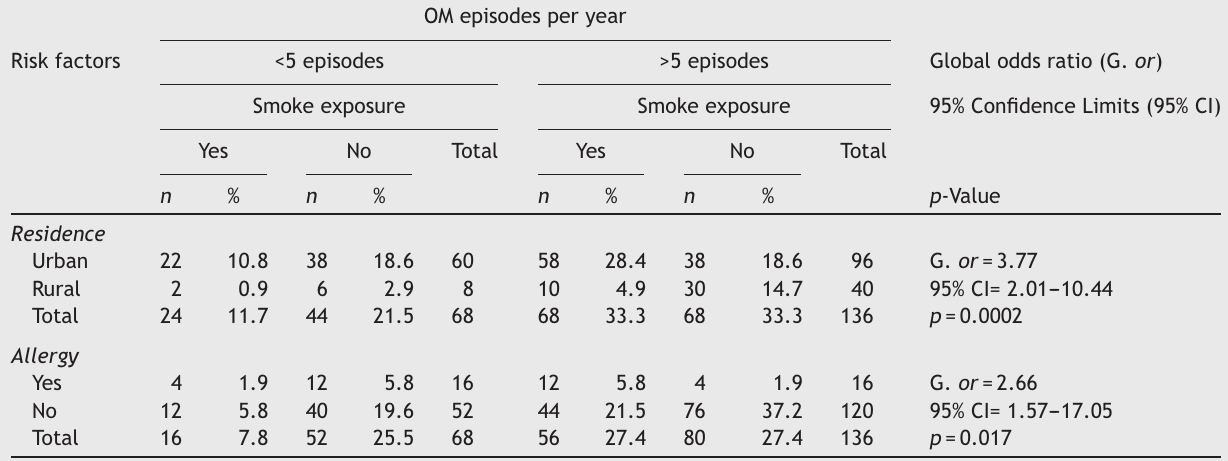
Cases: smoke exposure vs. no smoke exposure. Multivariate logistic regression analysis of OM